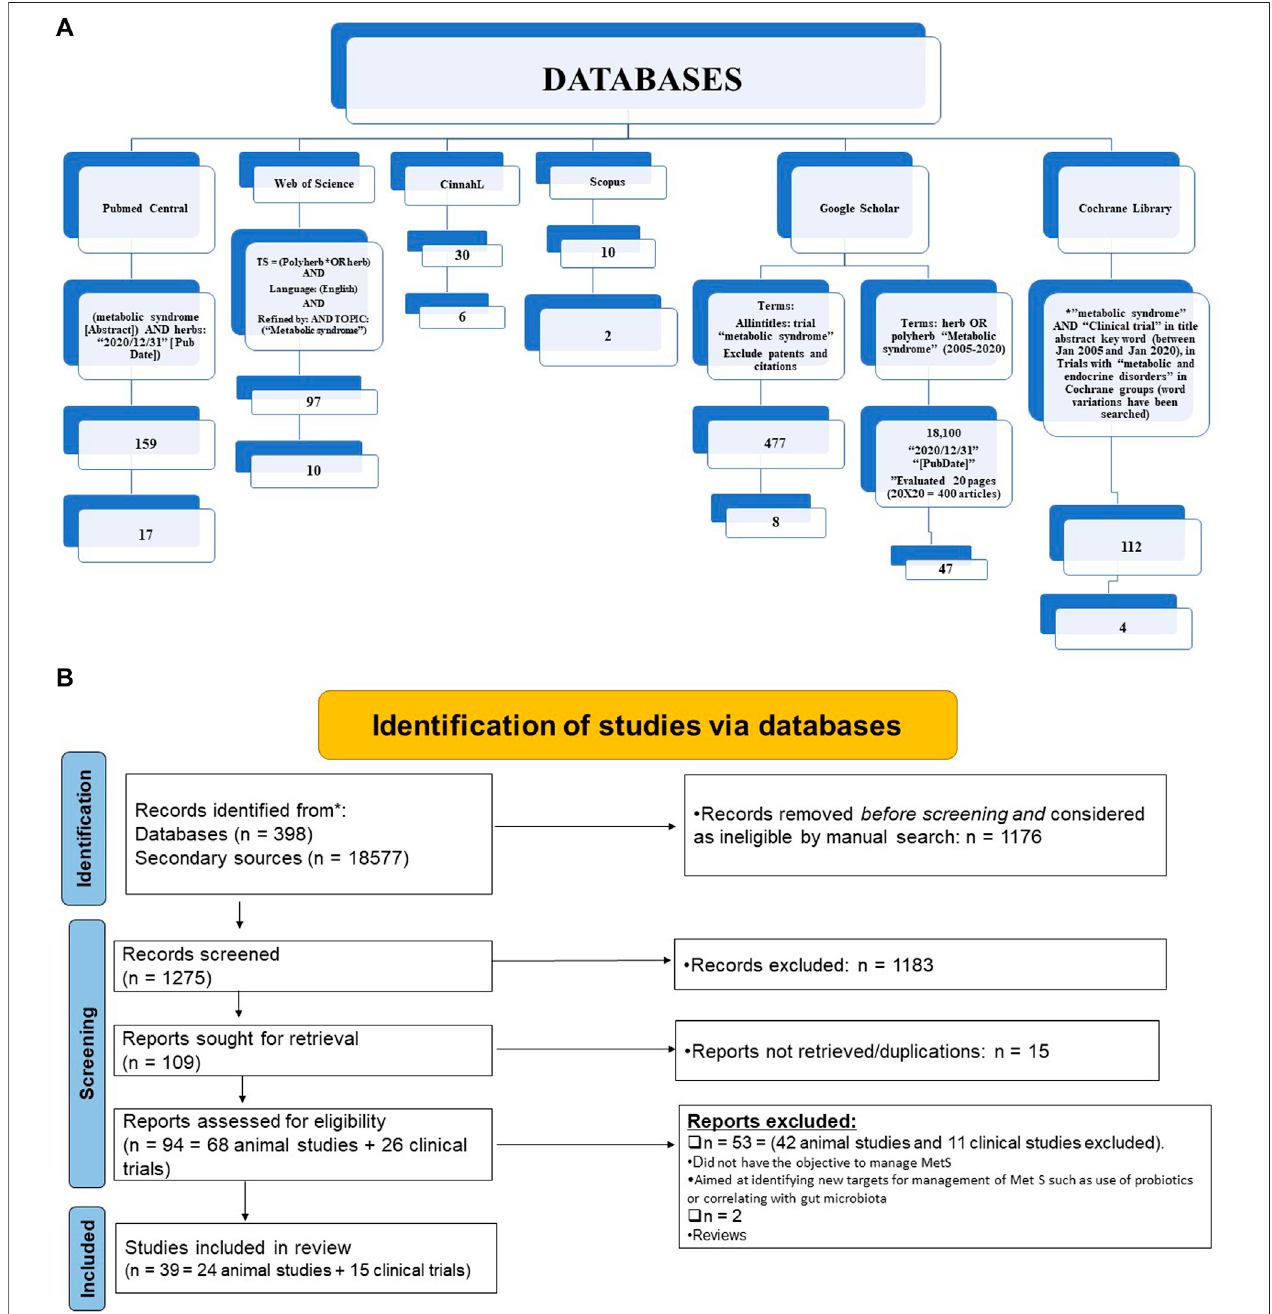
FIGURE 1 | Summary of literature search (A) and Analysis of systematic review results according to Prisma guidelines (B) .